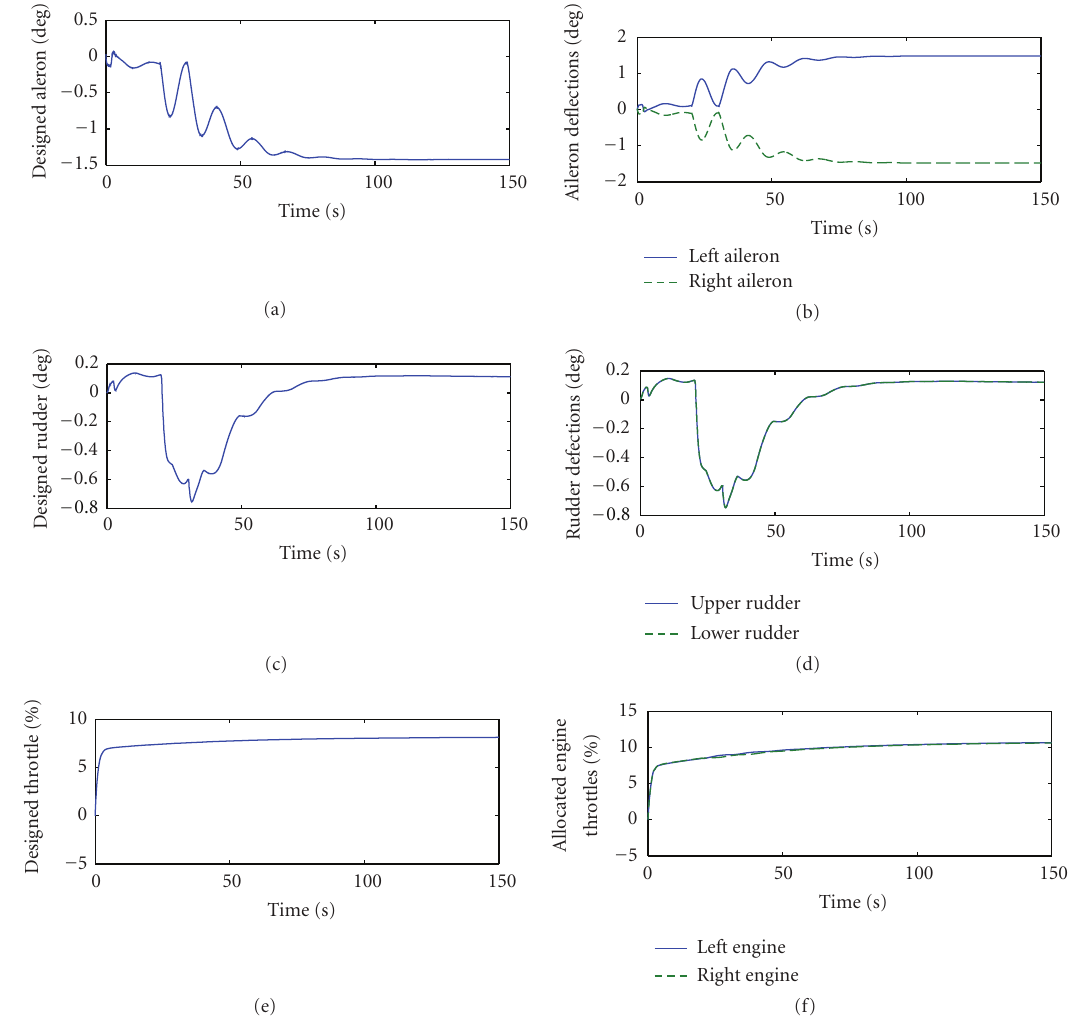
Figure 21: Time history of the inputs and outputs of ailerons, rudders, and engines.